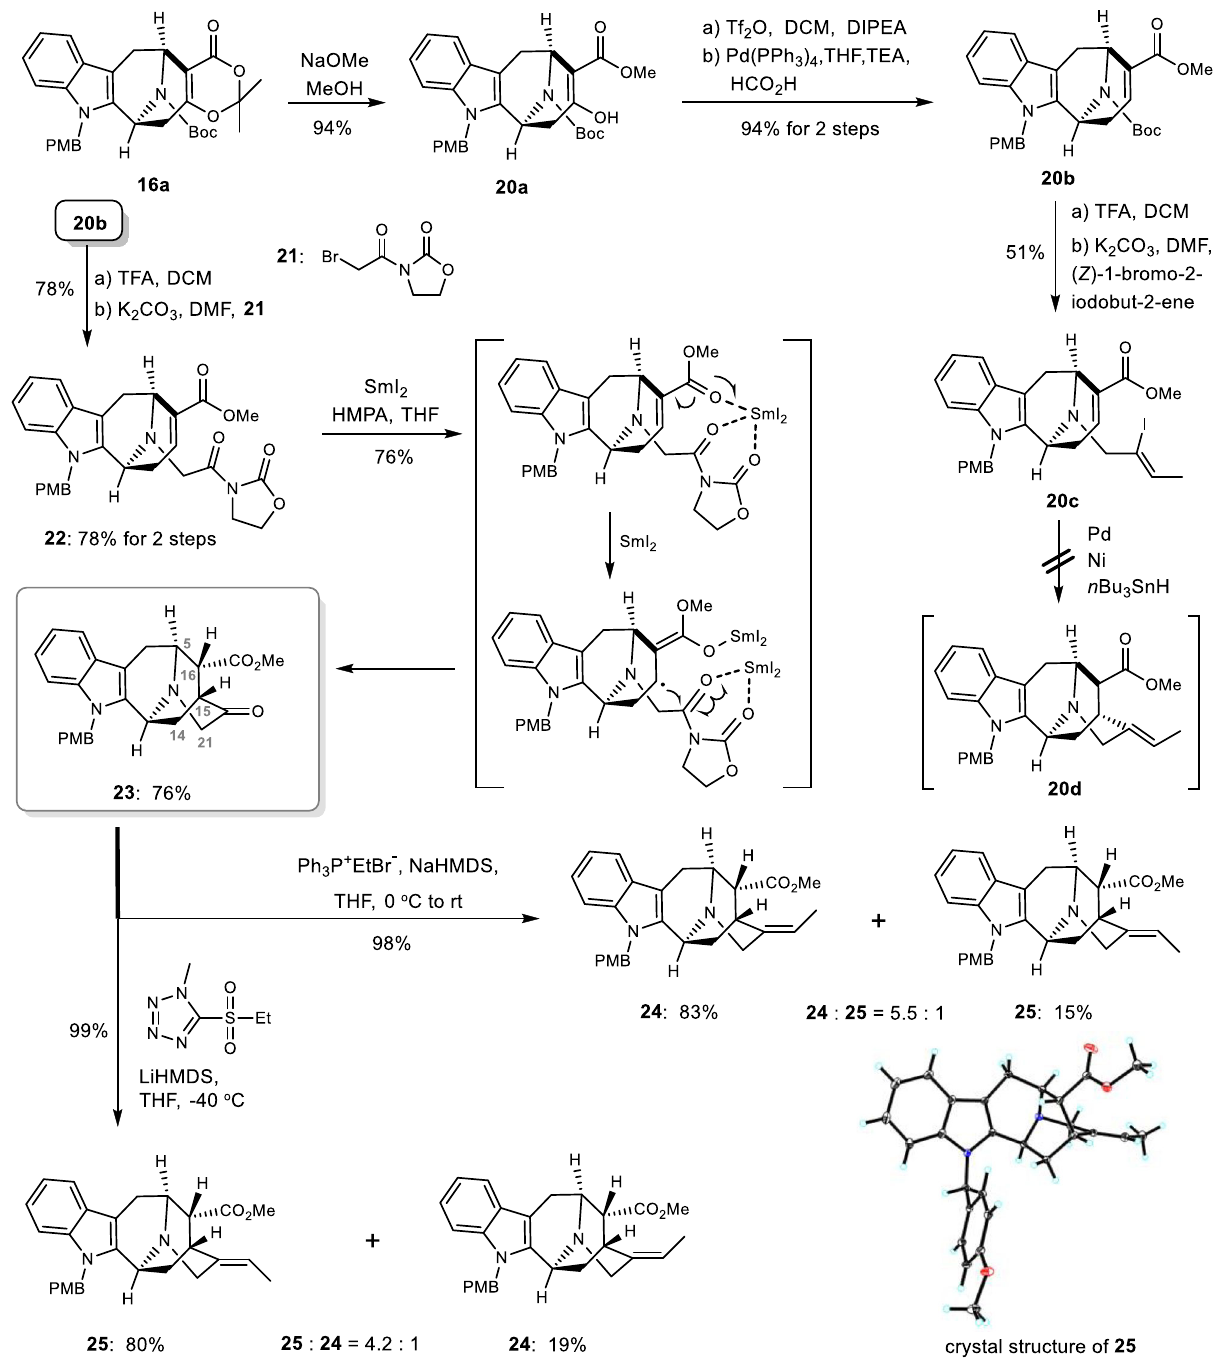
Fig. 4 Synthesis of the common sarpagine type skeletons. After construction of the bridged E-ring via SmI 2 mediated SET reaction, the double bonds were assembled by Wittig reaction ( E -selectivity) and Julia ole fi nation ( Z -selectivity). DIPEA diisopropylethylamine, DMF N , N -dimethylformamide, HMPA hexamethylphosphoramide, Me methyl, Ph phenyl, TEA triethylamine, Tf tri fl uoromethanesulfonyl, TFA tri fl uoroacetic acid, Et ethyl, NaHMDS sodium